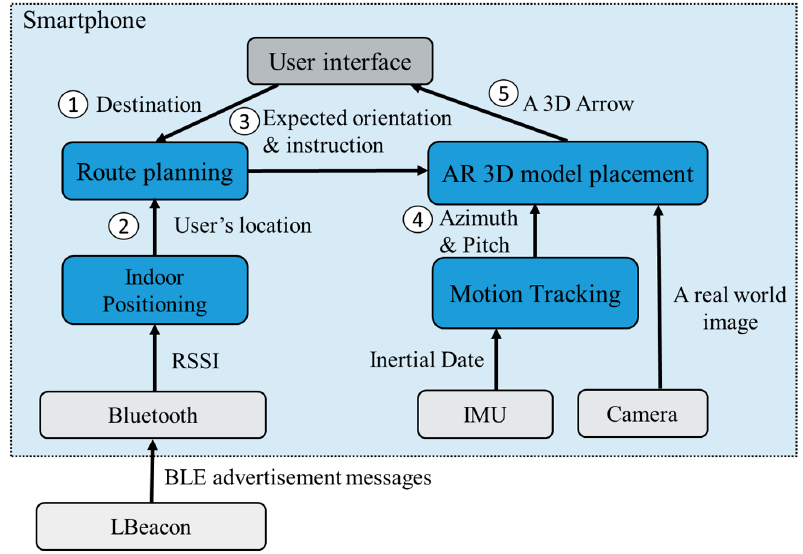
Figure 1. System architecture of ARBIN.